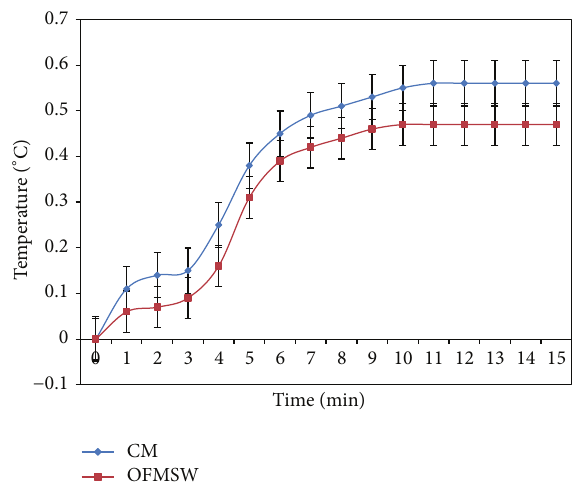
Figure 4: Temperature-time plot for determination of calorific